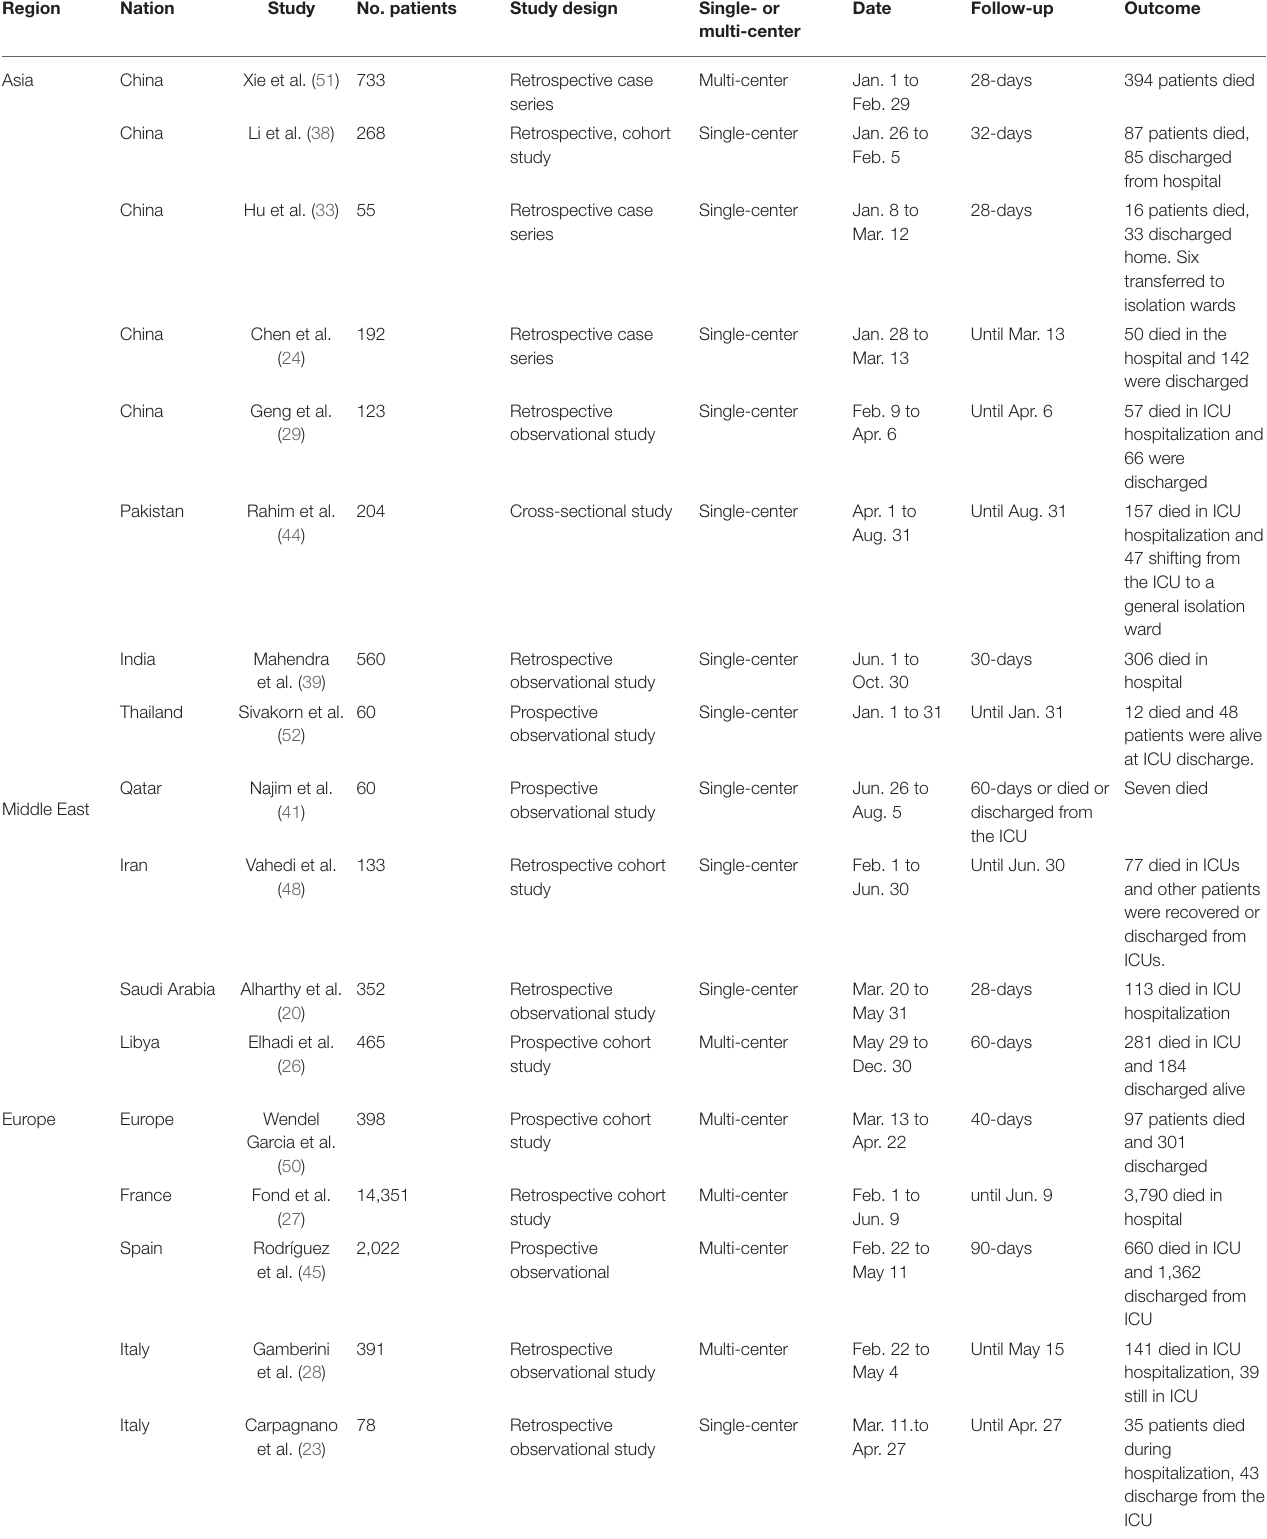
TABLE 1 | Basic characteristics of included studies of mortality of critically ill patients. Region